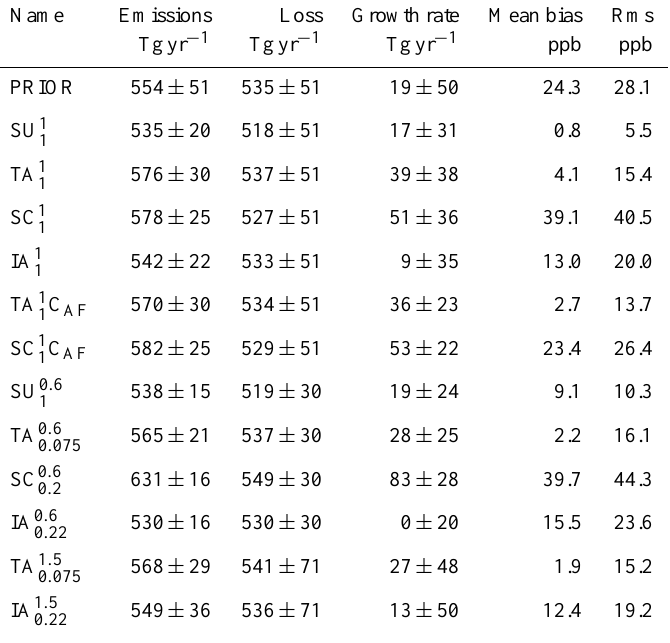
Table 3. Global emissions, chemical losses, growth rates of methane, fit to surface sites described by the absolute mean bias and rms. XX α γ where XX is a two-letter code specific to each observing system (SC for SCIAMACHY, TA for TANSO-FTS, IA for IASI and SU for surface sites); α and γ are the multiplicative factors associated with the covariance matrices B (see Sect. 3.1) and R (see Sect. 3.3). Name Emissions Loss Growth rate Mean bias Rms Tgyr − 1